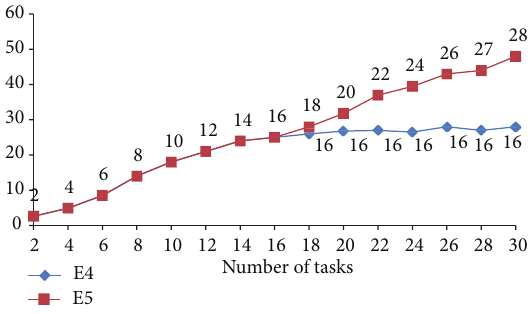
Figure 4: Results of the experiments with limited resources.